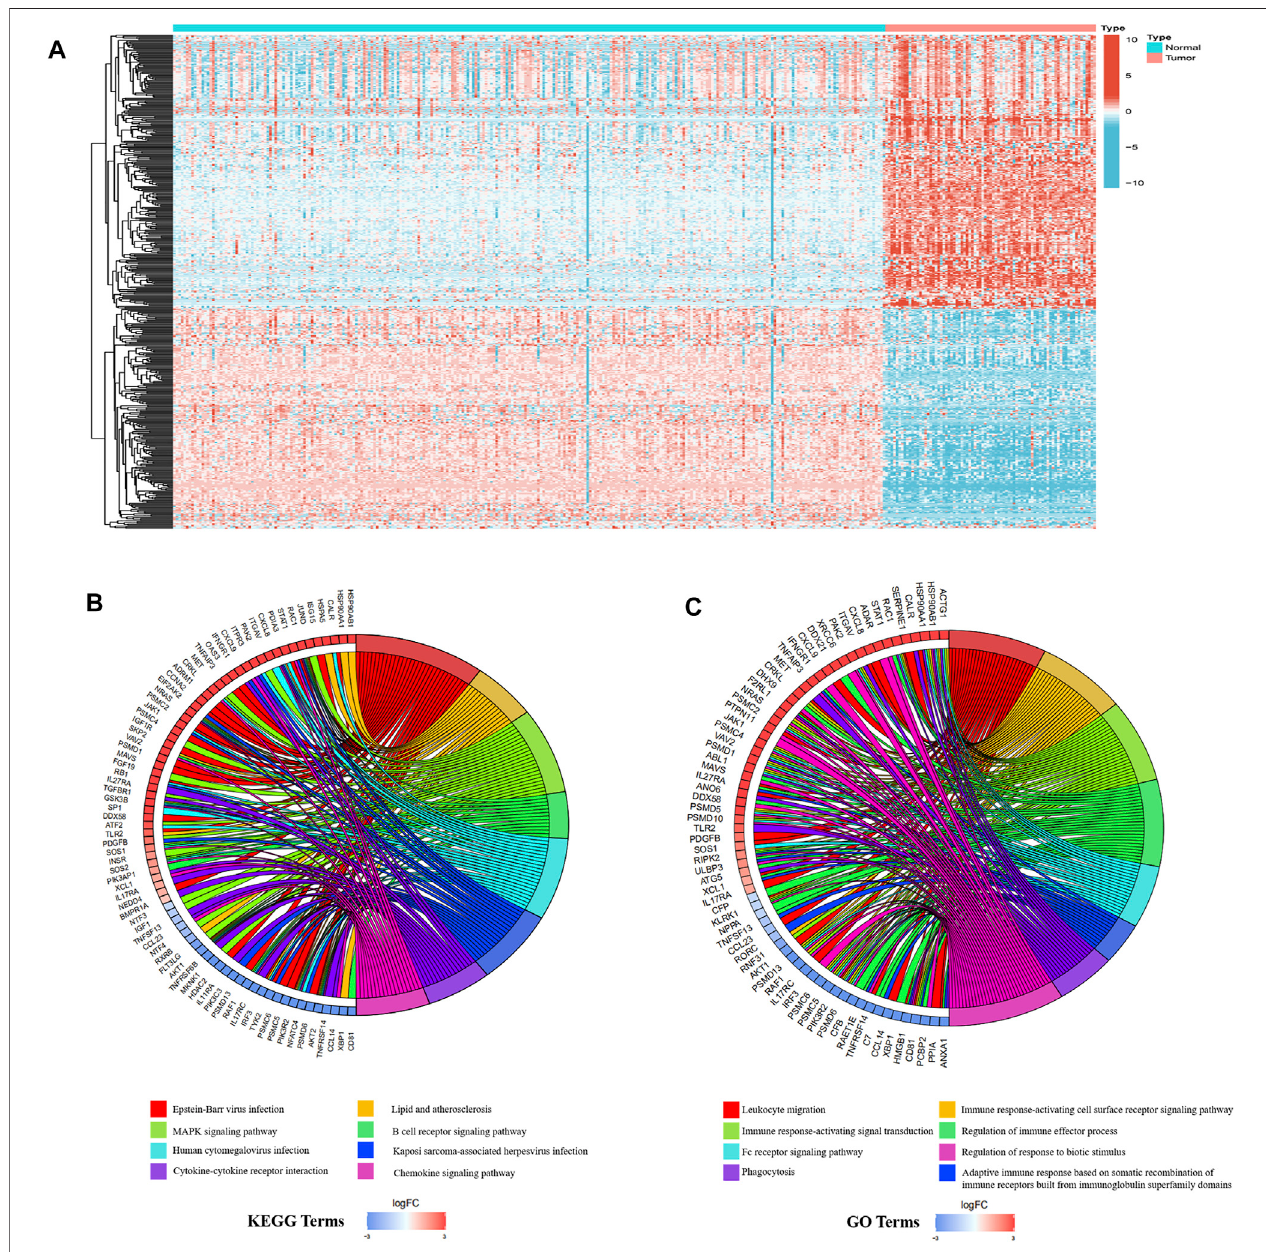
FIGURE 2 | Differentially expressed immune-related genes in ESCC and normal tissues. (A) The heatmap of different immune-related genes. (B) KEGG analysis results. (C) GO analysis results.